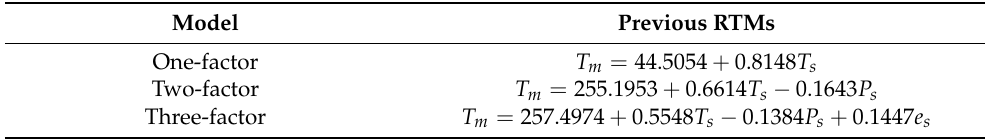
Table 5. Previous RTMs in the Yangtze River Delta Table 6. Precision statistics of yearly multifactor RTMs (K). Table 6. Precision statistics of yearly multifactor RTMs (K).